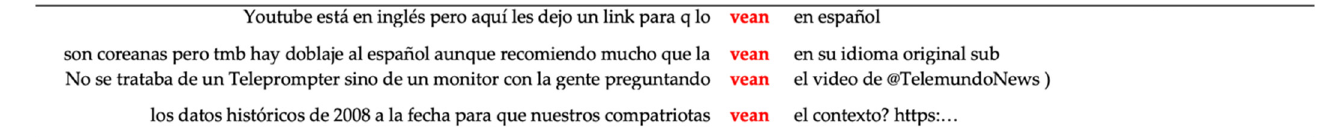
Figure 7. Concordance lines for vean that illustrate the use of tweets in the Spanish corpus directing readers to links.